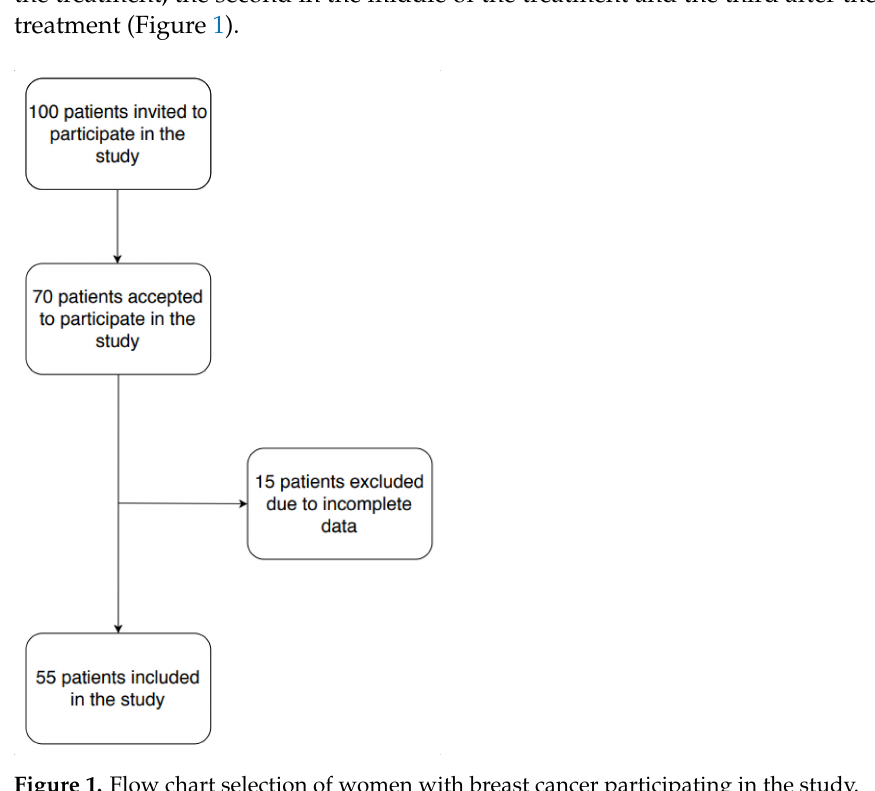
Figure 1. Flow chart selection of women with breast cancer participating in the